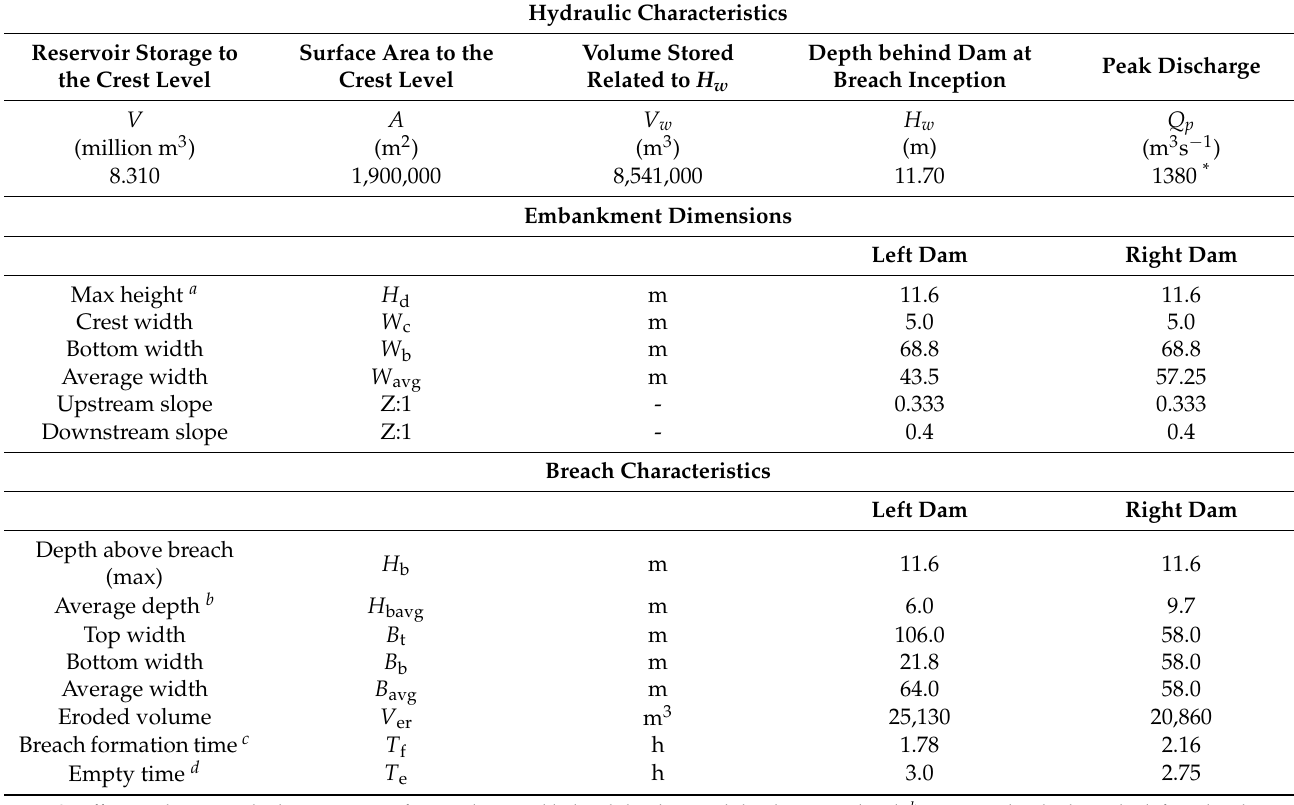
Table 2. Characteristics of the dam’s